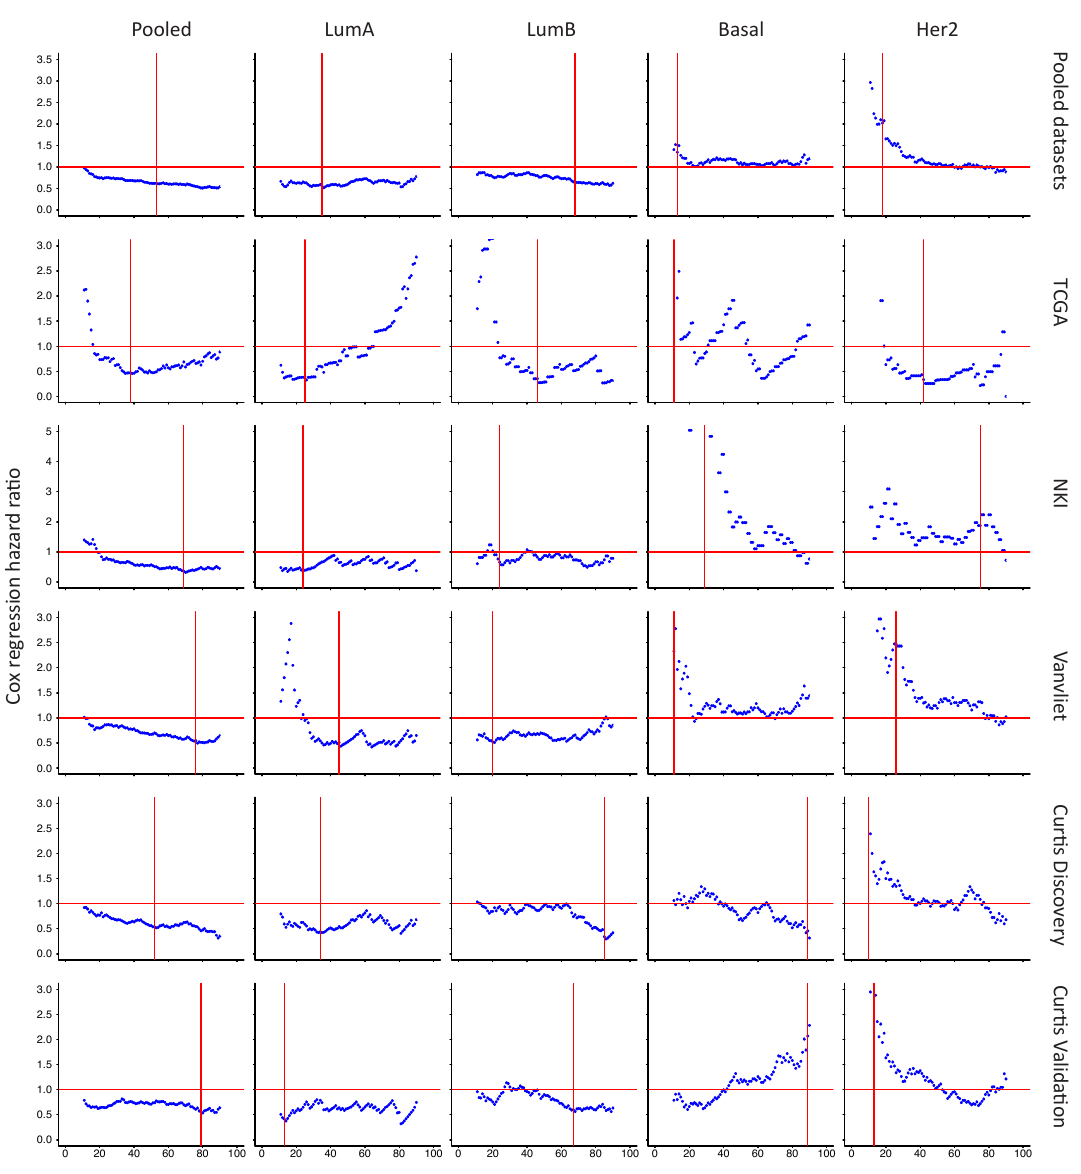
Figure A11. Cox regression hazard ratio associated with GJA1 for different thresholds. Graph of the Cox regression hazard ratio to compare the survival of patients with Cx43 expressed at high or low levels according to varying thresholds (10–90 percentile). Horizontal red lines indicate a neutral hazard ratio of 1. Vertical red lines indicate the threshold with the lowest log rank test p value as determined in Figure A10, used for subsequent survival analysis. Results given for pooled tumors or individual breast cancer subtypes in our five datasets (TCGA, NKI, Vanvliet and Curtis discovery and Curtis validation) as well as in aggregated datasets (Pooled